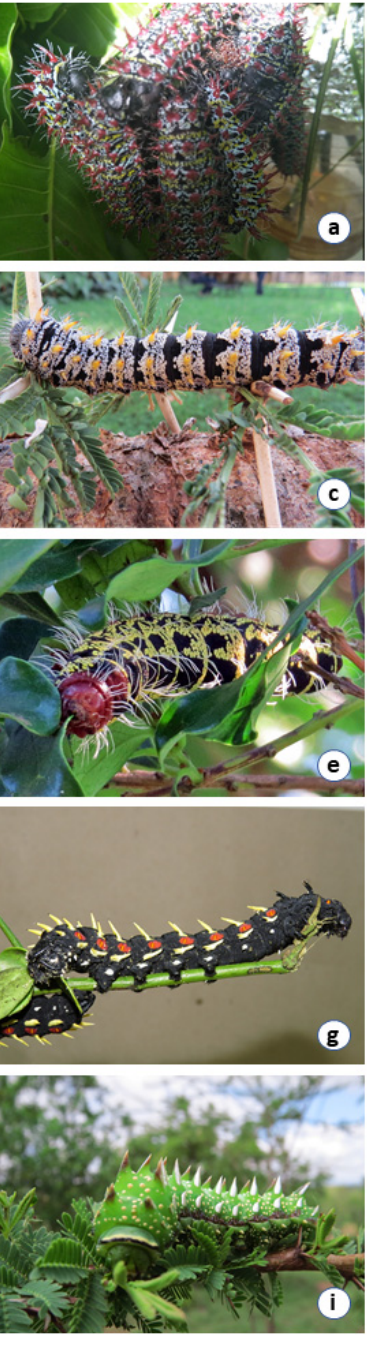
Figure 2. Pictures of saturniid larvae. ( a ) Gonimbrasia zambesina larvae with red spines, ( b ) Gonimbrasia zambesina larvae with black spines, ( c ) Gonimbrasia cocaulti , ( d ) two color forms of Gonimbrasia krucki larvae; black with green speckles and black with yellow speckles, ( e ) Cirina forda larva black in color with yellow spots, ( f ) Cirina forda larva black in color with white spots, ( g ) Bunaea alcinoe black form observed in East Africa, ( h ) Bunaea alcinoe red form observed in West Africa, ( i ) Gynanisa nigra larvae, ( j ) Gonimbrasia belina collected in Kenya.